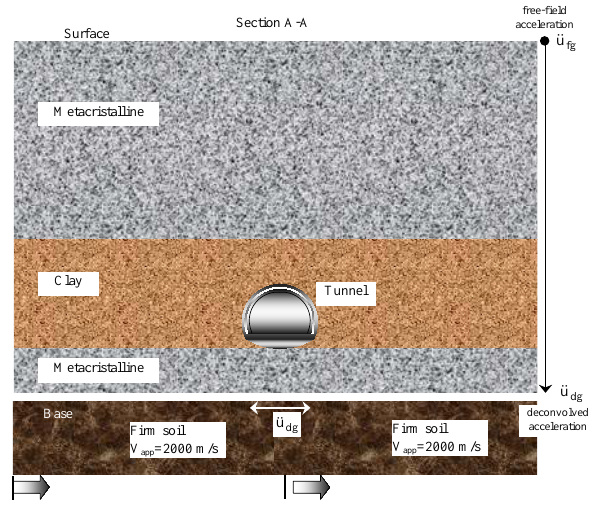
Fig.3. Materials surrounding A-A cross section of the Bolu Tunnel to random earthquake ground Fig. 3. Materials surrounding A-A cross section of the Bolu Tunnel motion to random earthquake ground motion. 5. Input Ground Motions of acceleration and velocities of Kocaeli earthquake record The stochastic analysis of the Bolu tunnel is performed for random earthquake ground motion is depicted in Figs. 4 and 5, respectively. The strong motion by taking into account the incoherence and wave passage effects. For this purpose, two different near- records are obtained from the PEER Strong Motion Database fault earthquake ground motions are considered in the analyses for the tunnel-soil deposit interaction (PEER, 2012). This database gives information about the site system supports. conditions and the soil types for the instrument